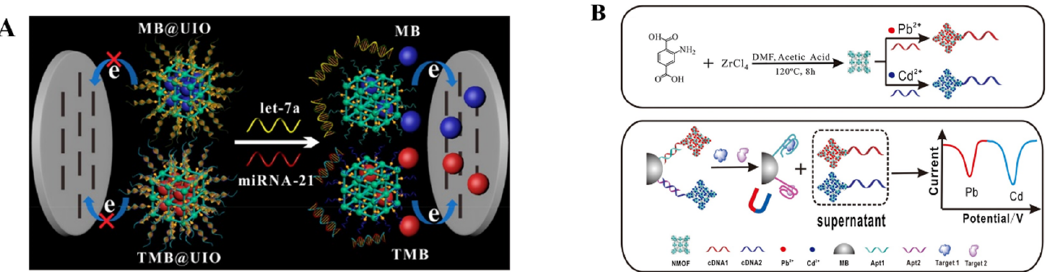
Figure 7. ( A ) Schematic illustration of the principle of an MOF − based homogeneous electrochemical biosensor for the multiple detection of miRNAs (let-7a and miRNA-21). Reprinted with permission from Ref. [204]. Copyright 2019, American Chemical Society. ( B ) Schematic illustration of the synthesis of UiO-66-NH 2 nanoparticles and preparation of two signal probes, and the simultaneous electrochemical detection of KANA and CAP, based on aptamer-nanoscale MOFs as biocodes. Reprinted with permission from Ref. [207]. Copyright 2017, Elsevier.